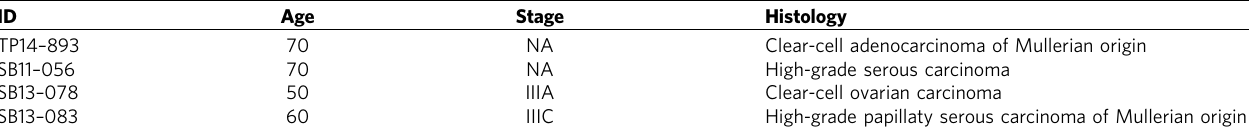
Table 1 | Patient